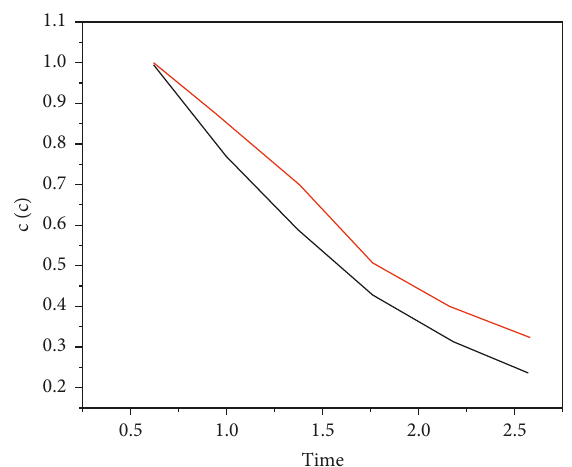
Figure 5: Degradation curves of methylene violet by the two